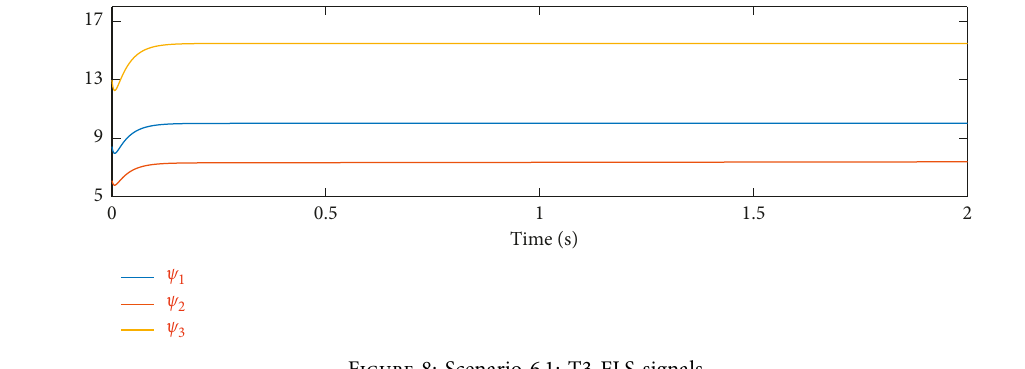
Figure 8: Scenario 6.1: T3-FLS signals.